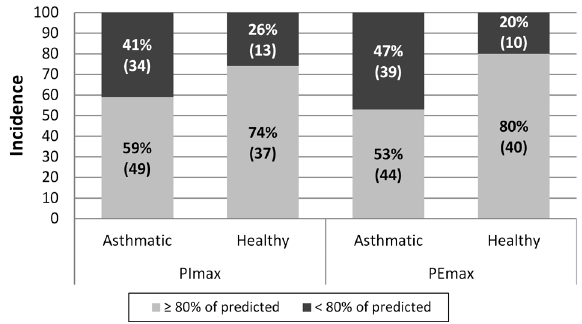
Figure 1. Distribution of maximal inspiratory (PI and maximal expiratory (PE girls with asthma compared to healthy girls.